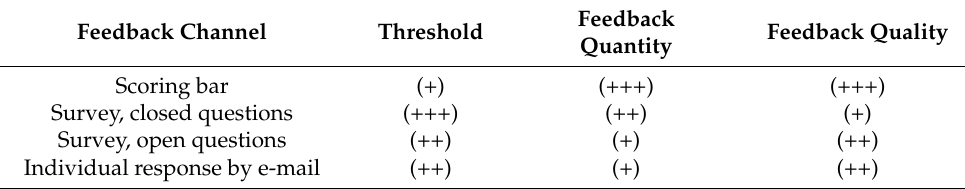
Feedback Feedback Quality Quantity